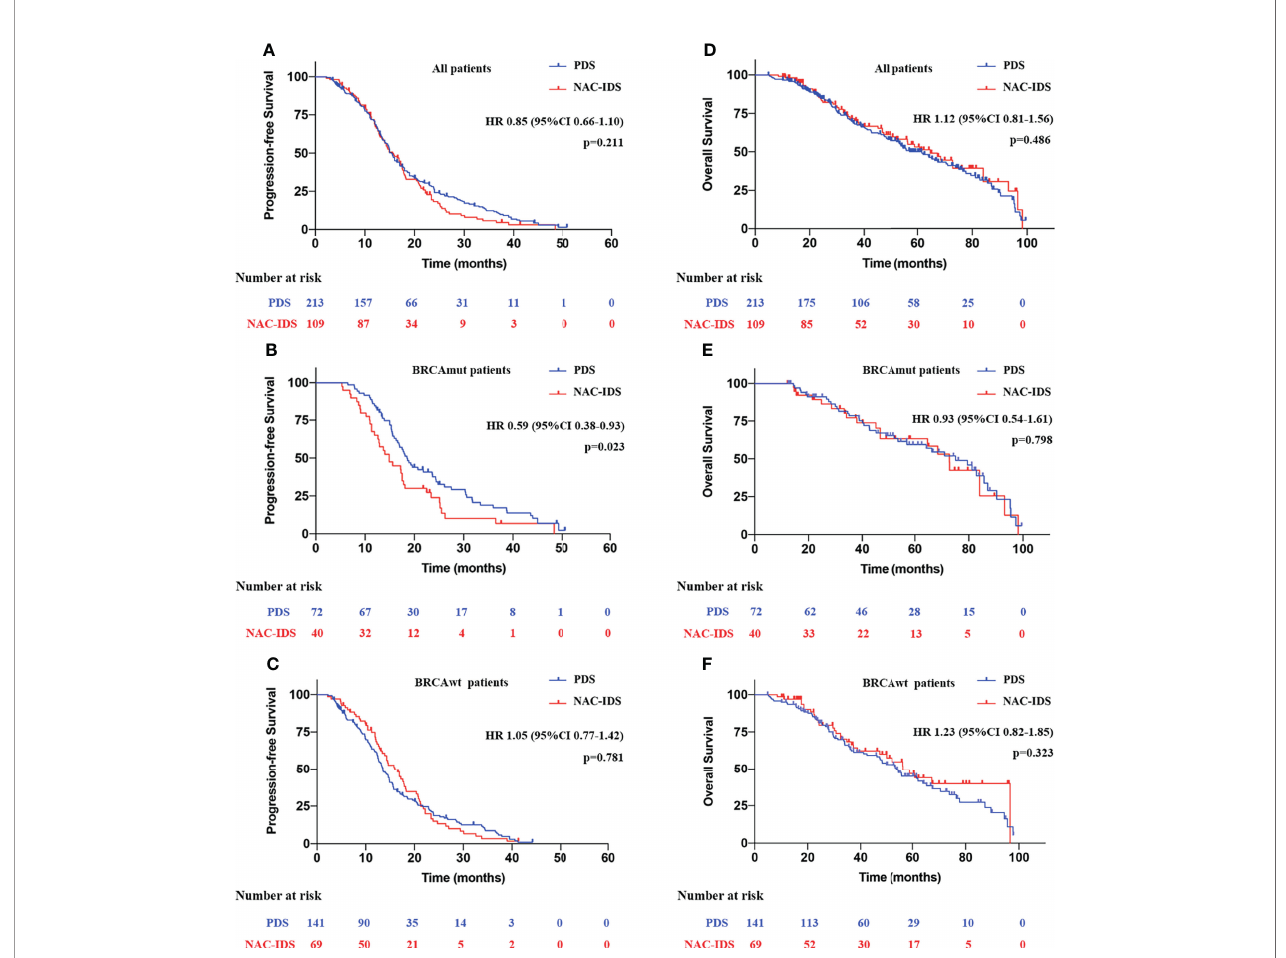
FIGURE 2 | Survival analysis of patients with NAC-IDS and PDS. (A, D) Survival analysis of all patients included in the study. (B, E) Survival analysis of BRCAmut patients. (C, F) Survival analysis of BRCAwt